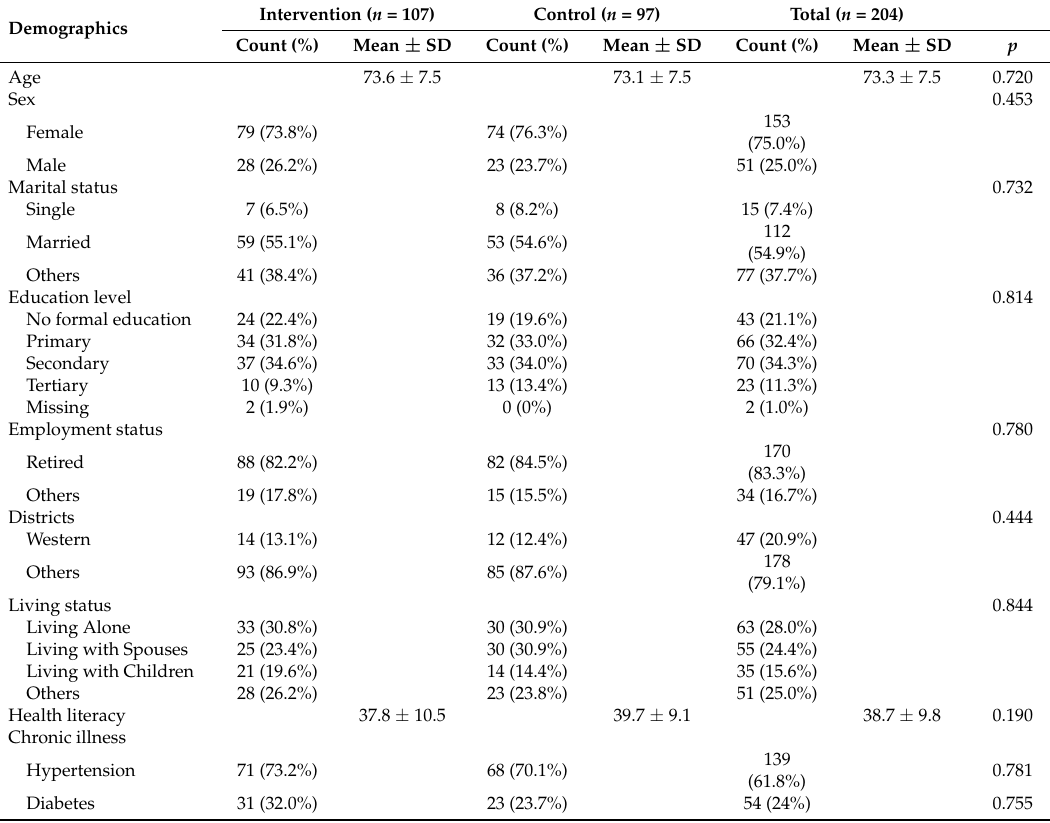
Table 1. Participants’